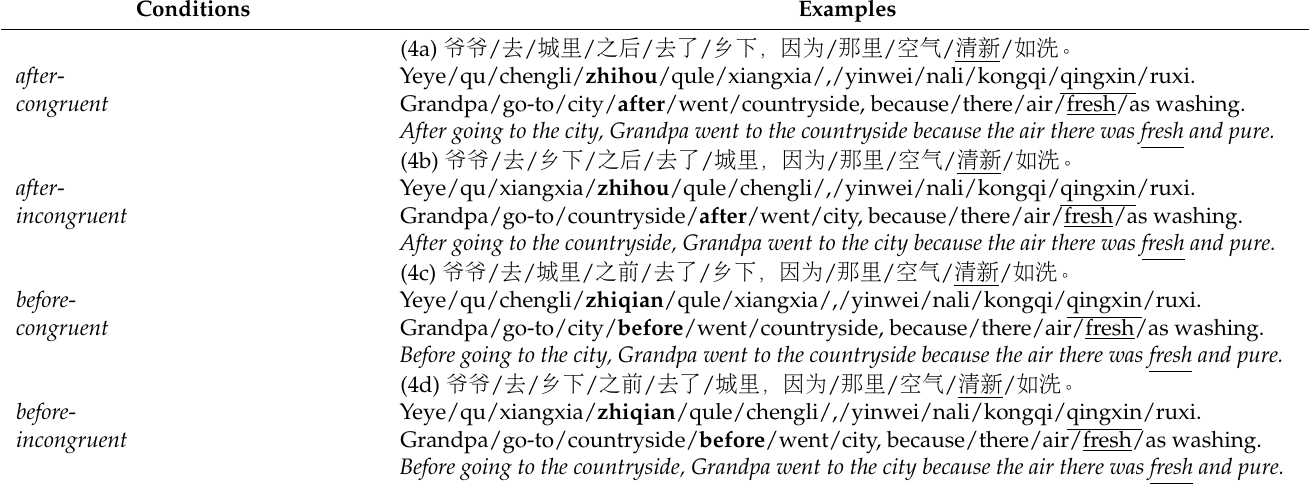
Table 2. Experimental conditions and example sentences with literal translations and